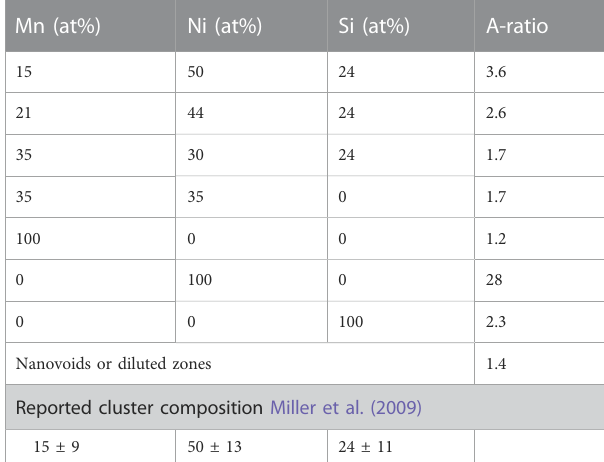
TABLE 3 A-ratios calculated for selected compositions of Mn-Ni-Si-rich clusters (rest Fe). Mn (at%) Ni (at%) Si (at%)